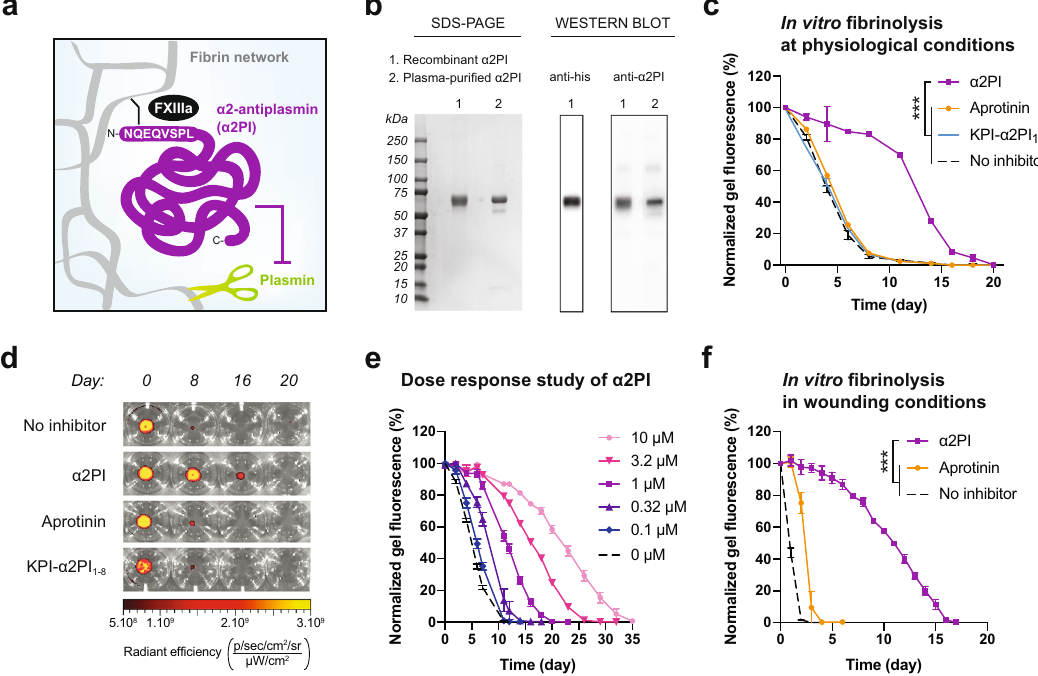
Fig. 1 Recombinant human α 2PI protects fi brin biomaterials more effectively than the clinical protease inhibitor aprotinin. a Schematic view of α 2PI enzymatically crosslinked into fi brin by Factor XIIIa (FXIIIa) at its N-terminus and inhibiting plasmin-mediated fi brinolysis. b SDS- PAGE and western blot analysis of recombinant α 2PI, under reducing conditions, as compared to the commercially available α 2PI puri fi ed from human plasma. c Degradation of fi brin containing 1 μ M of α 2PI, aprotinin, KPI- α 2PI 1 – 8 or no inhibitor in presence of 2.5 nM of plasmin. Fibrinolysis is monitored via reduction in fi brin fl uorescence over time. d Representative images of the degradation of fi brin gels containing the different inhibitors, as presented in c . e Ef fi cacy of α 2PI in protecting fi brin biomaterials at different concentrations ranging from 0 to 10 μ M, in the presence of 2.5 nM of plasmin. f Ef fi cacy of α 2PI (15 μ M) to slow fi brinolysis in the presence of 25 nM of plasmin, mimicking the increased activity of plasmin in wounding conditions. Mean ± standard deviation (SD). Statistical comparisons were done using ANOVA test with Dunnett ’ s post-hoc test: *** p -value <